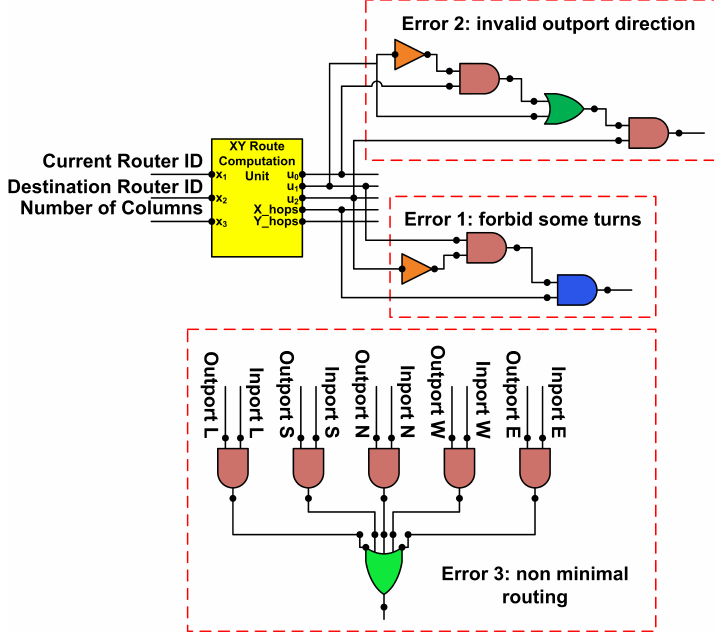
Figure 4. Fault Detection Circuitry for RC